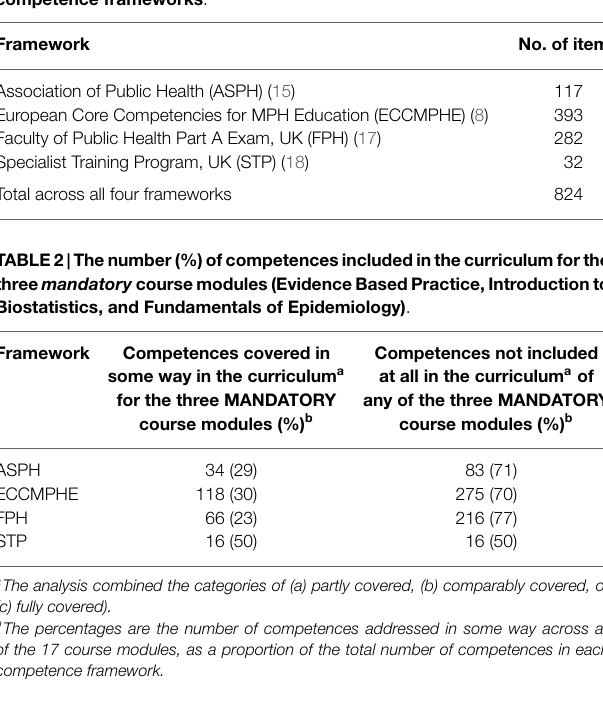
TABLE 1 | The number of competence items covered in each of the competence frameworks